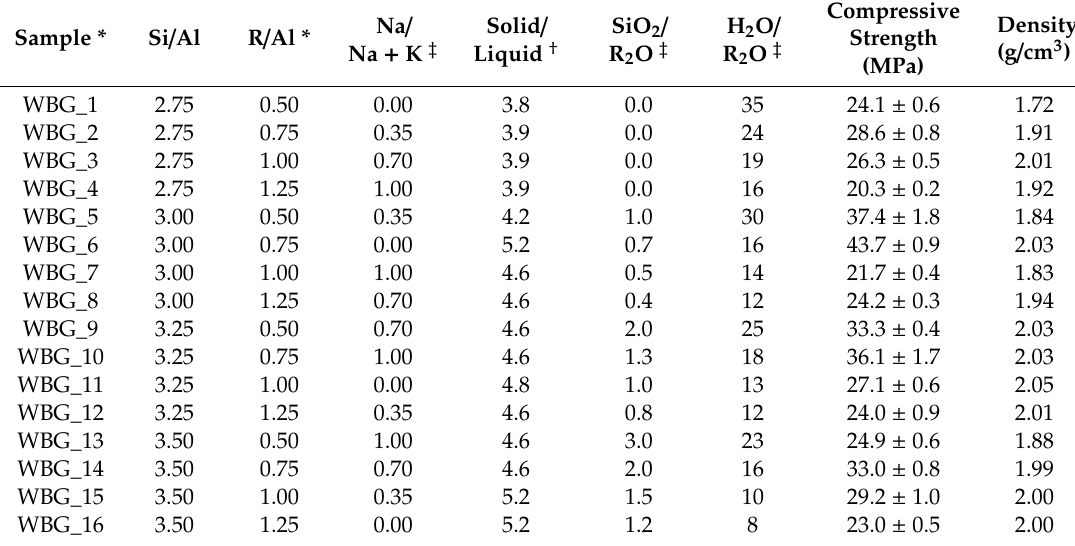
Table 5. Synthesis parameters, compressive strength and density of the final